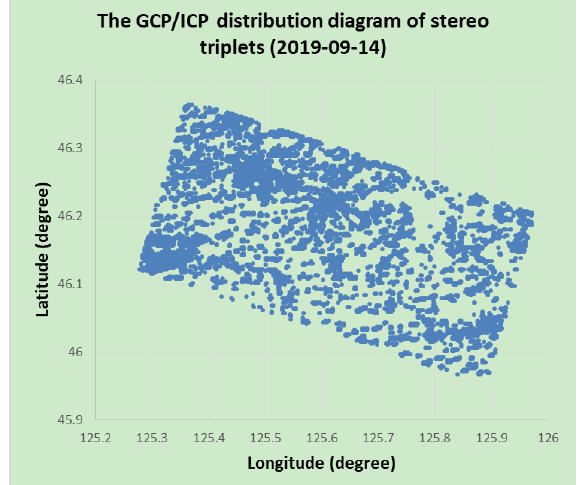
Figure 3. The GCP/ICP distribution diagram of stereo triplets (2019-09-14)